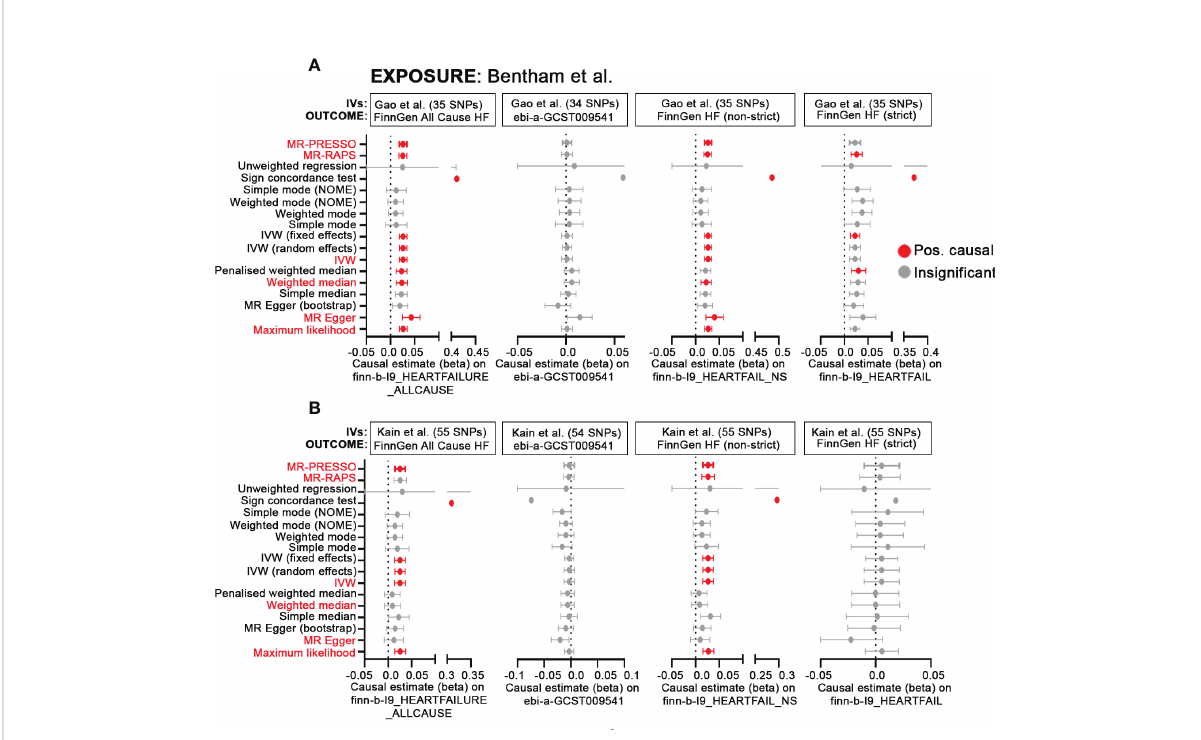
statistics from the Bentham et al. GWAS (5) were used for the exposure. For results, grey indicates insigni fi cant (p> 0.05), red, positive causal estimates (p<0.05) determined by each MR method. Red text indicates MR methods included in Gao et al. In (A) , IVs published in Gao et al. were derived solely from the Bentham et al. GWAS; for (B) , IVs were sourced from multiancestral datasets (5 – 7) and are published in Kain et al.